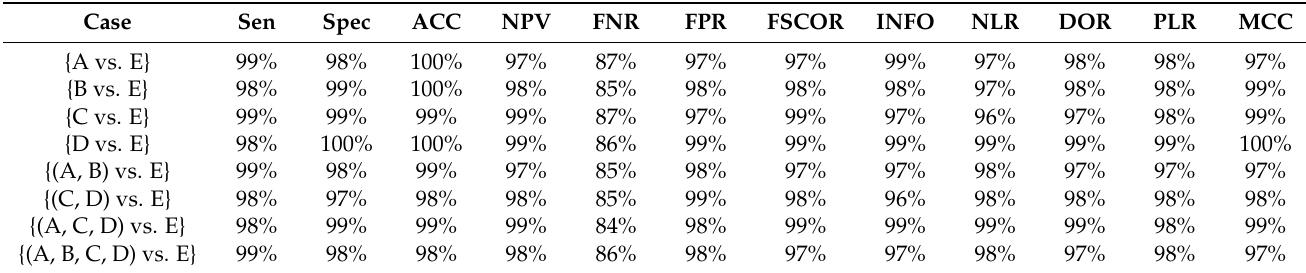
Table 6. Classification accuracy under feature selection.